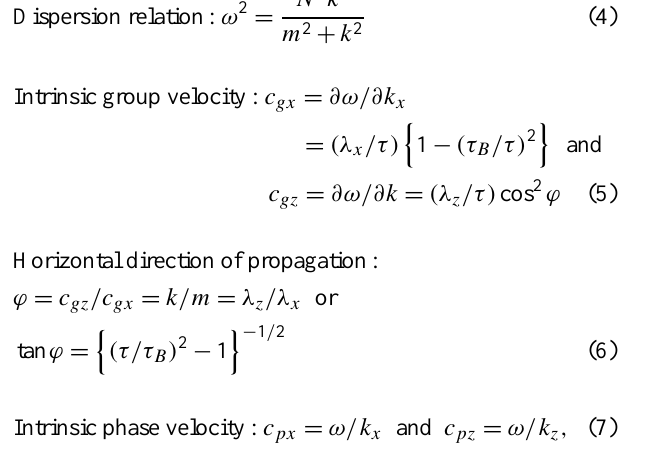
and − 1.8 (dissipative) for Event 1 and − 1.75 (mature) and − 1.85 (dissipative) for Event 2. The slopes in the strato- sphere are found to be − 1.15 (initial); − 1.5 (mature) and − 1.5 (dissipative) for Event 1 and − 1.6 (mature); − 1.6 (dis- sipative) for Event 2.